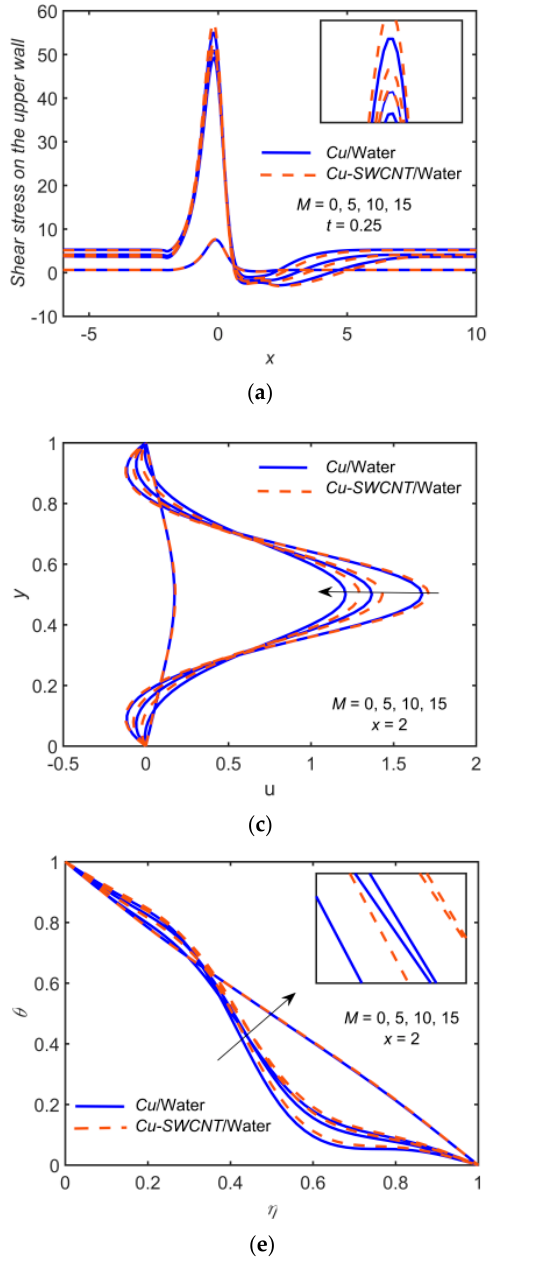
Figure 3. ( a ) The WSS distribution, ( b ) 𝑢 profile at 𝑥 = 0 , ( c ) 𝑢 profile at 𝑥 = 2 , ( d ) θ profile at 𝑥 = 0 , ( e ) θ profile at 𝑥 = 2, and ( f ) φ profile at 𝑥 = 0 for distinct values of 𝑀 .